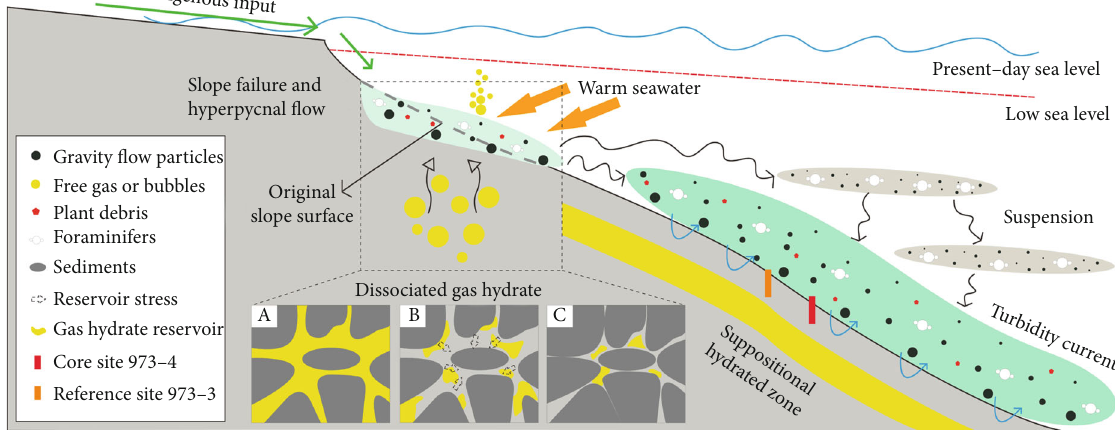
Figure 5: A conceptual picture showing the possible processes, including the occurrence of turbidite, sediment delivery, and sedimentation due to the slope failure induced by gas hydrate dissociation. The three drawings in the bottom display the evolution of the hydrated reservoir from a microscopic aspect during gas hydrate dissociation owing to unstable environmental condition. (a). When formed within sediment, gas hydrate fi lled into pores and cemented particles with high saturation, resulting in an increase in bulk sediment strength (b). When the perturbations to the thermodynamic equilibrium of the gas hydrate system occurred due to the change of sea level and seawater temperature, hydrate began to dissociate from the stability zone (hydrated zone). This process released water and free gas, which di ff used upward to the subsurface layer or even to the sea fl oor shaped as gas plumes, accordingly, the strength in sediments decreased, and sediment particles showed a tendency to be compressed (the dotted arrows) (c). As the hydrate dissociates and gas releases, the sediment particles were redistricted, and the reservoirs became instability. Consequently, those factors were su ffi cient to trigger an occurrence of submarine landslide and then induced the turbidity current. The turbidity current transported large block of sediments into the deep ocean along the steep slope; fi nally, the fi ne materials in suspension deposited on the top of coarse particles. The exogenous components mixed with in situ marine sediments and redeposited on the sea fl oor, which caused the destruction of the original deposition sequence with certain